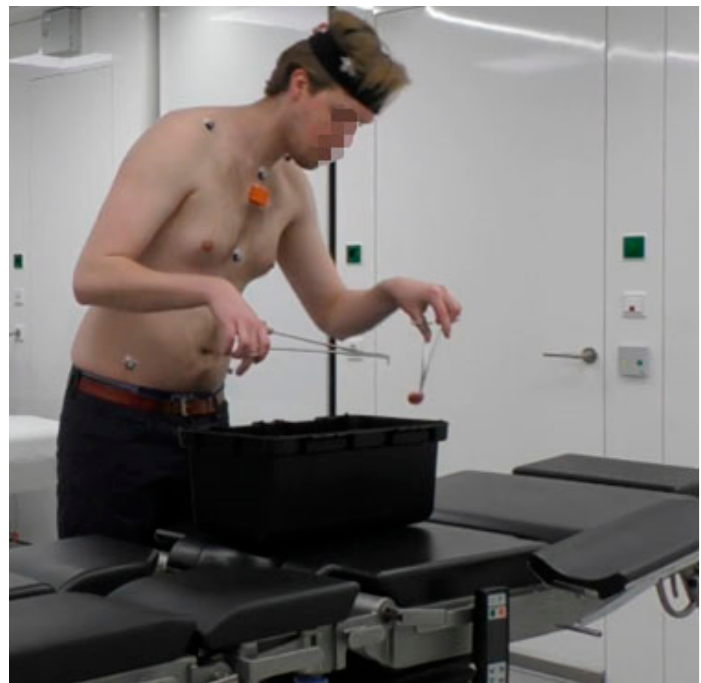
Figure 3. Example of simulated surgical tasks. Table 1. Detail of simulated surgical task.